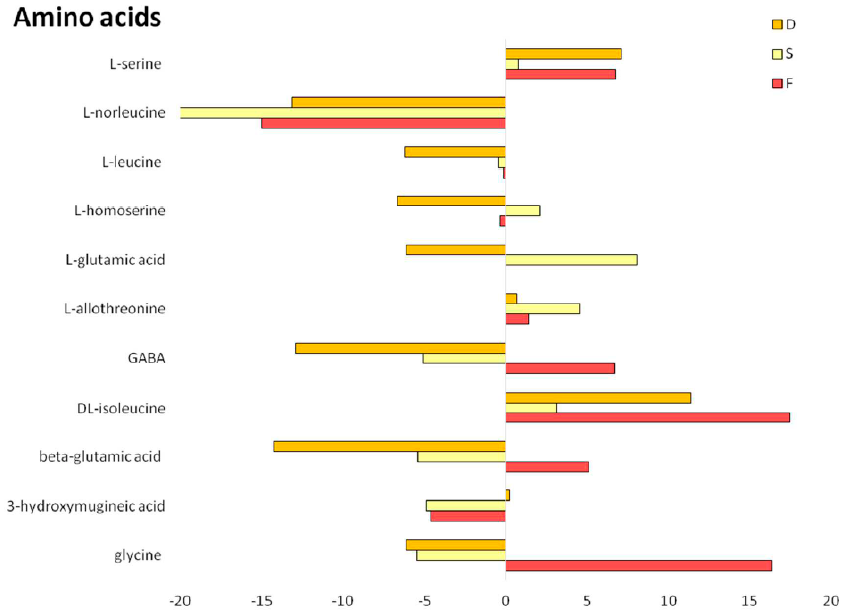
Figure 6. Changes in amino acids release induced by di ff erent nutritional regimes. Amino acids in root exudates from tomato plants subjected to di ff erent nutritional treatments (C = control, F = Fe deficiency, S = S deficiency, D = dual deficiency). The figure shows metabolites that change significantly in F, S or D condition with respect to control samples p < 0.001) and changes are expressed as fold changes (treatment / control